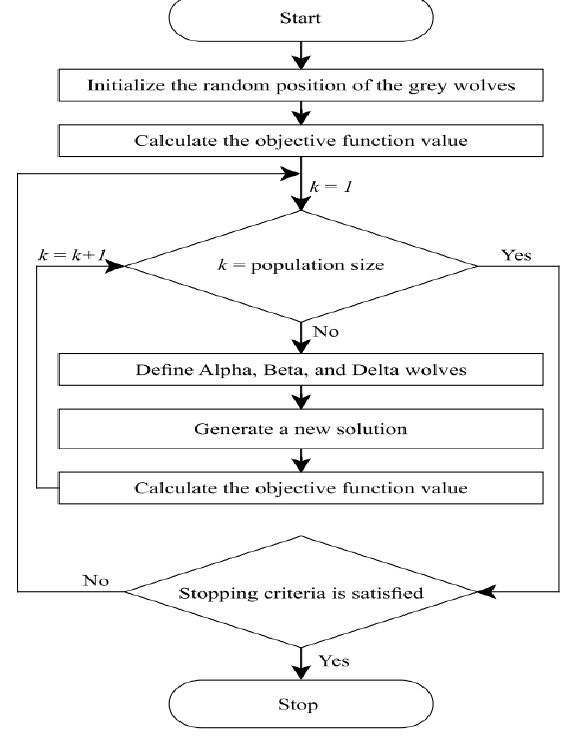
Figure 14. The Grey Wolf algorithm flowchart.